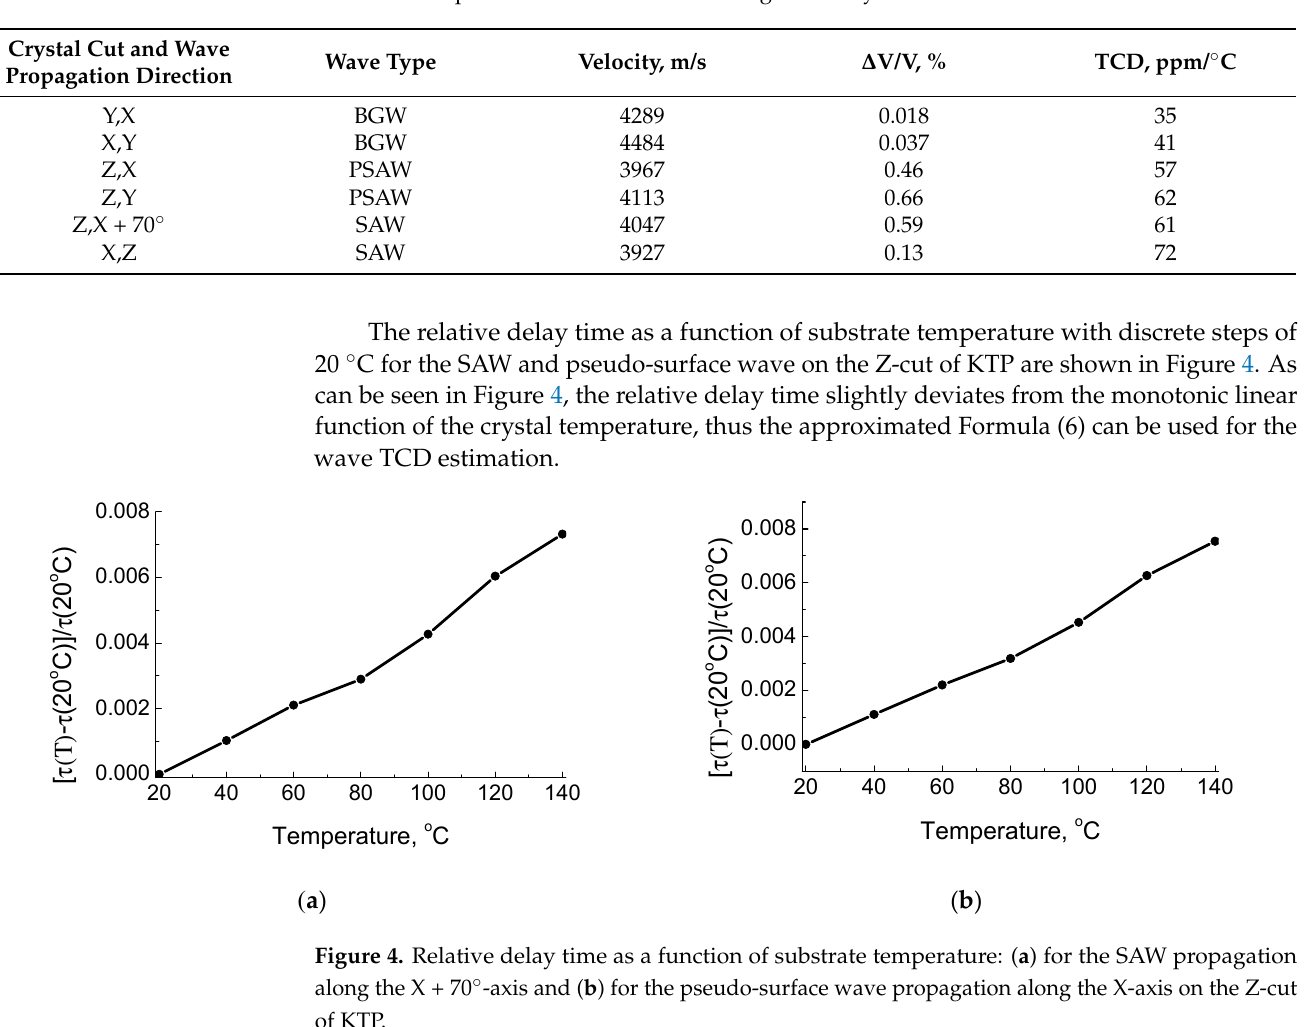
Table 1. SAW parameters on the different single KTP crystal cuts.